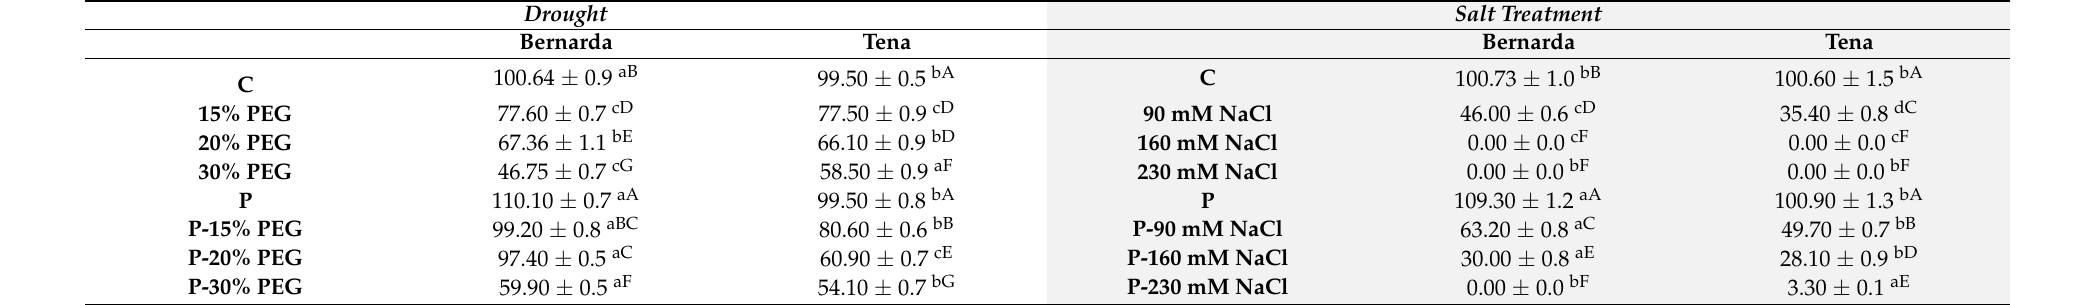
Table 5. Root length (mm) of two wheat genotypes after 5 days of growth under control (C), drought treatments (15%, 20% and 30% PEG), salt treatments (90, 160 and 230 mM NaCl), high voltage electrical discharge (HVED) pretreatment (P) and combined (P-15% PEG, P-20% PEG, P-30% PEG, P-90 mM NaCl, P-160 mM NaCl and P-230 mM NaCl) treatments. Values are means of three repetitions (10 plants/repetition) ± S.D. The different capital letters indicate significances among means of different treatments within the same genotype, while lowercase letters indicate significances among means between genotypes under the same treatment at p < 0.05 using LSD post-hoc